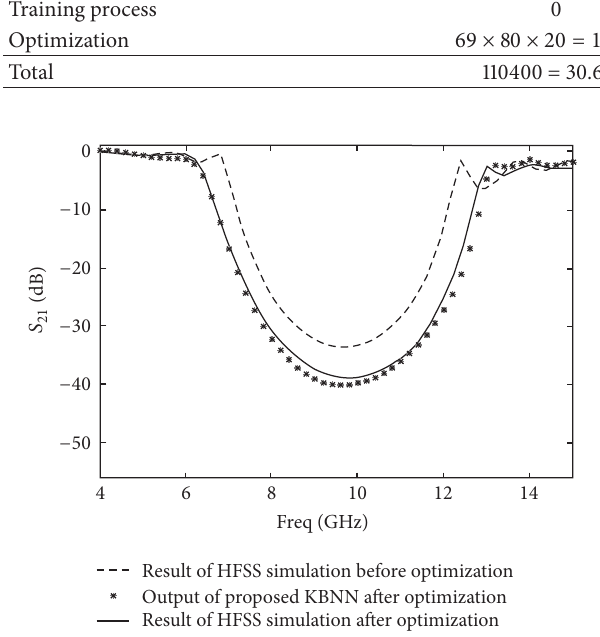
Figure 8: Comparison of tapered dual-plane EBG before and after optimization.